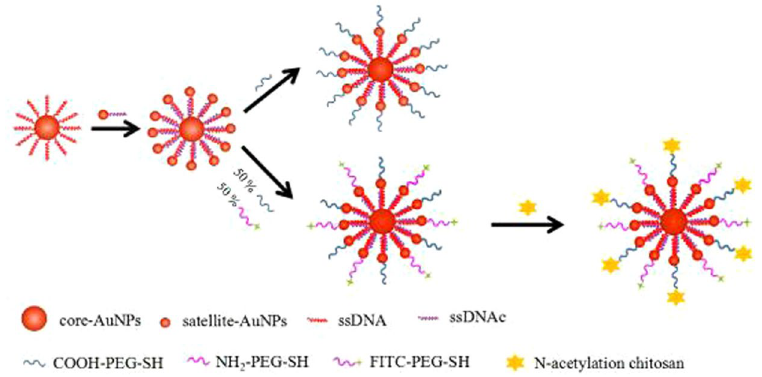
Figure 1. Schematic illustration of the DNA-directed self-assembly and surface modification of the “core- satellite”-shaped Au